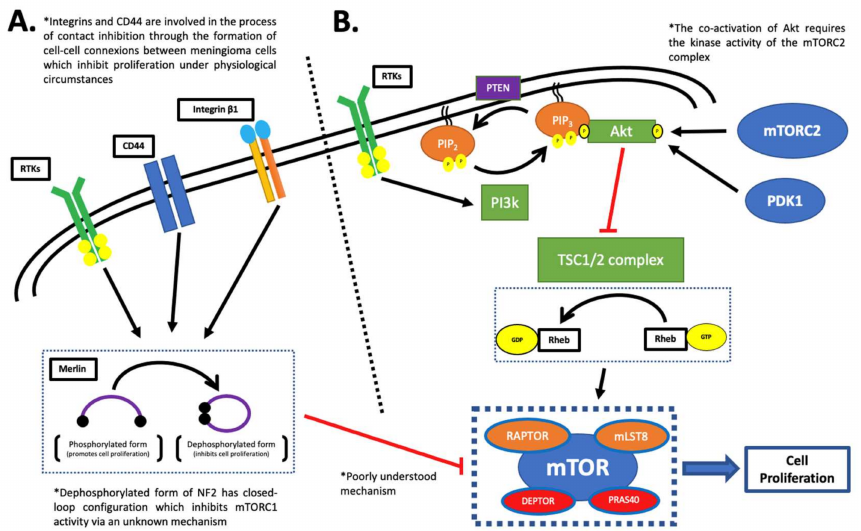
Figure 1. The activation of the mTORC1 complex. ( A ) The loss of NF2 is associated with increased mTORC1 activity via an unknown mechanism [22,23]. Contact inhibition, an important mechanism in meningeal cells, is reported to be involved in the upstream regulation of the protein. The contact inhibition is mediated by multiple proteins, such as RTKs, CD44, and integrin beta-1 [24–28]. ( * ) The ensuing activation of the merlin protein leads to mTORC1 inhibition through a poorly understood mechanism [22,23]. ( B ) The PI3K/Akt/mTOR pathway is a critical pathway in cell proliferation. The pathway is triggered by growth factors stimulative of RTK receptors [32]. The ensuing steps result in control of the TSC1/2 complex, the principal regulator of mTORC1 complex activity. TSC1/2 acts via Rheb, which activates the mTORC1 complex in the GTP-bound form to drive cell proliferation